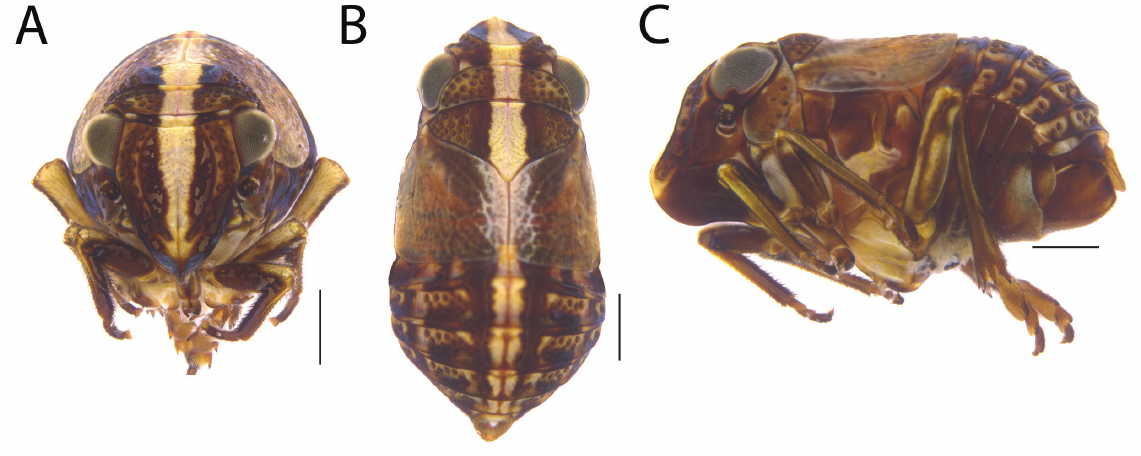
Fig. 9. Habitus of Bruchomorpha pseudodorsata sp. nov., ♀, holotype (INHS). A . Frontal view. B . Dorsal view. C . Lateral view. Scale bars = 0.5